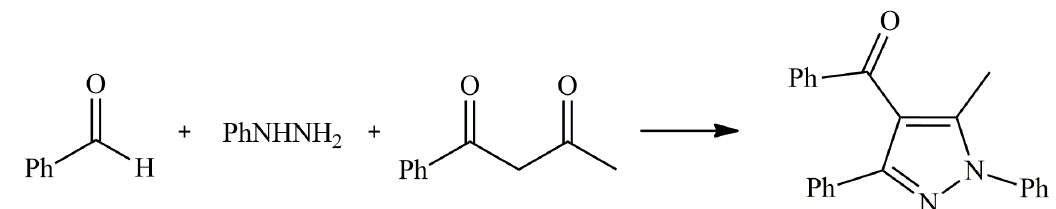
Figure 7. Synthesis of pyrazole by aldehyde, hydrazone and 1,3-diketone condensation. Several publications focused on biomass conversion into useful bio-based chemicals.